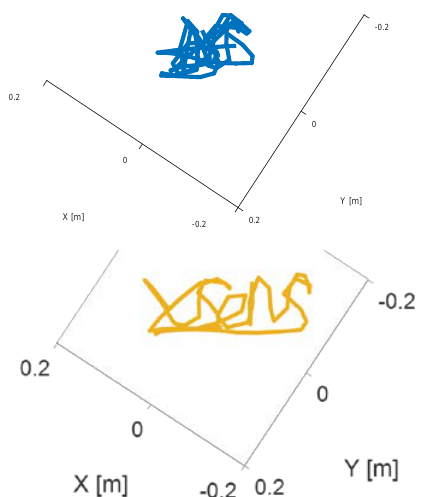
Figure 11: Recovered complex handwriting pattern using the ambient magnetic field. (Top) before performing GP-SLAM and (Bottom) after GP-SLAM.